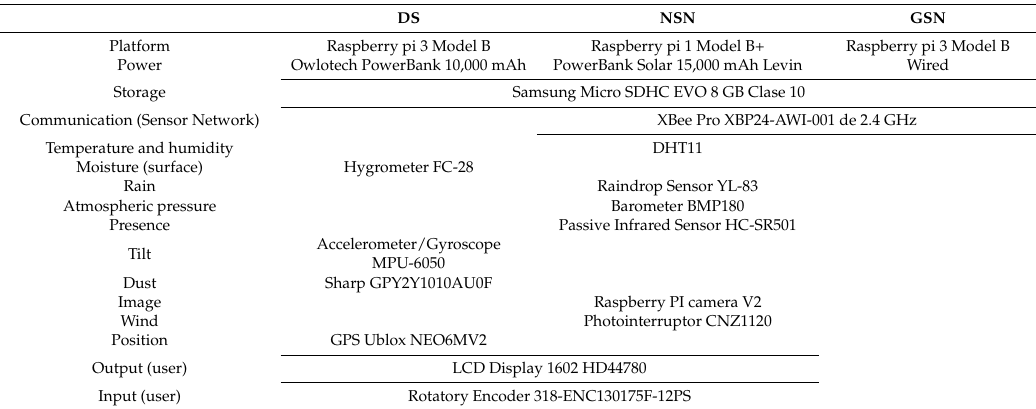
Table 4. Hardware Device